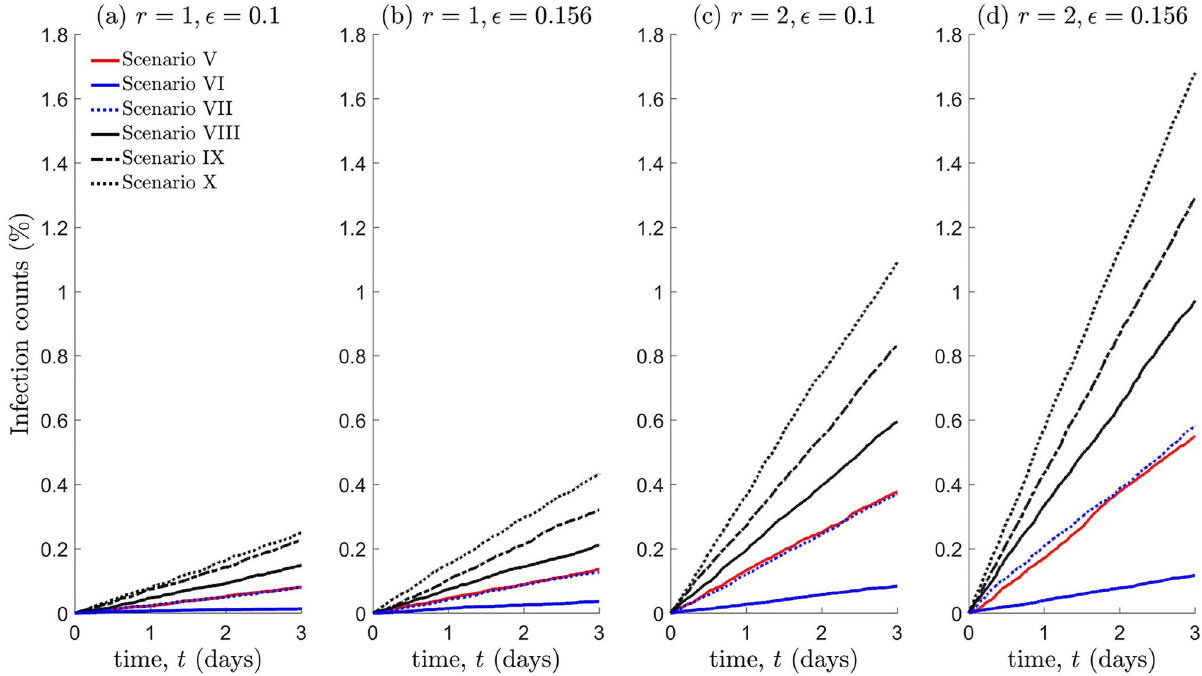
Fig 9. Infection counts for a heterogeneously distributed population, under the lockdown scenarios V-X shown in Fig 6. All other details are the same as that in the caption of Fig 8.